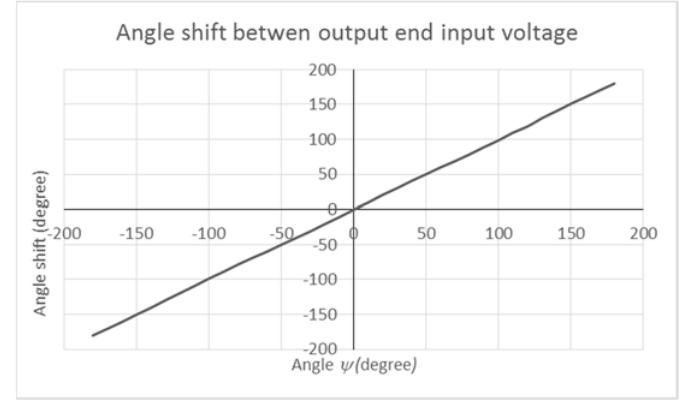
Figure 10. Angle shift between the output and input voltage versus the reference angle ψ